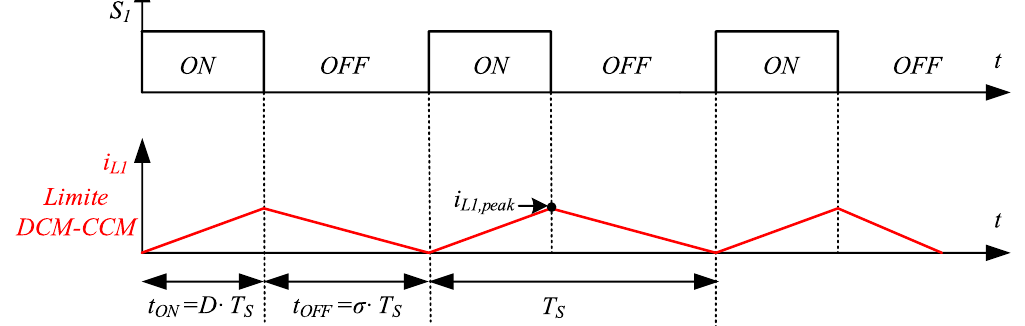
Figure 11. Limit between continuous and discontinuous conduction modes for the inductor L 1 . CCM, Continuous Conduction